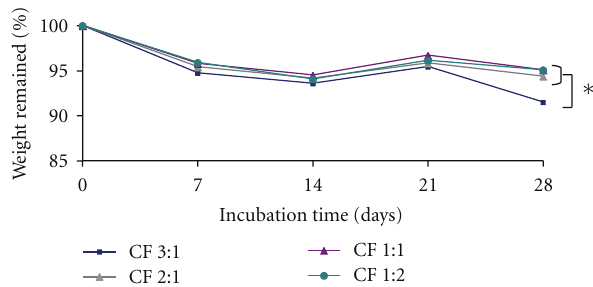
Figure 6: The percentages of remaining weight of CS/SF blend films with various blend ratios of chitosan :fibroin (CF) incubated in lysozyme solution at 37 ◦ C as a function of time. Each point represents mean ± standard error ( n = 3). One-way ANOVA showed a significant di ff erence in percent remaining weight among groups ( ∗ P < 0 . 05).